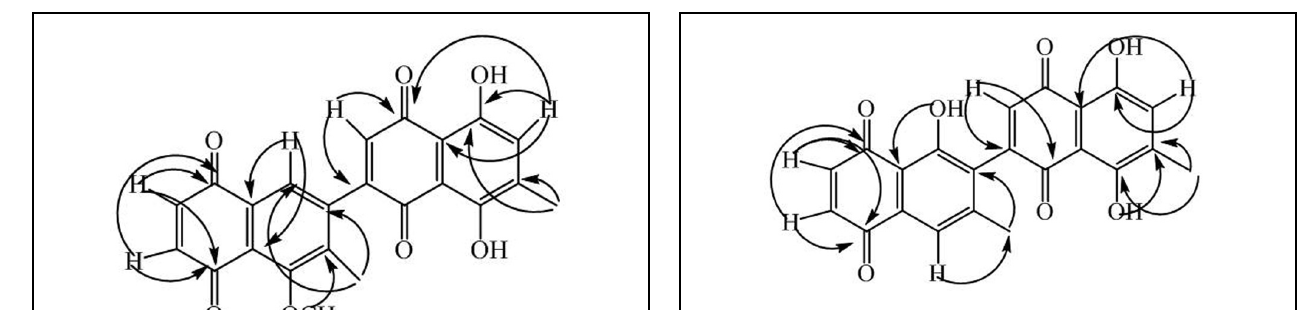
FIGURE 4 | Key HMBC correlations of compound 3.